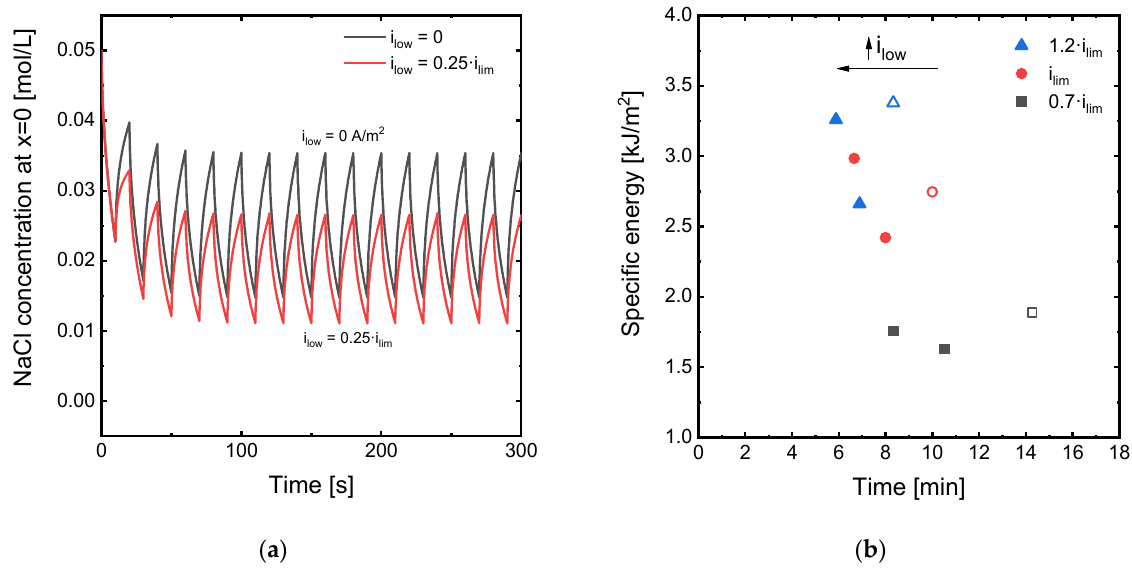
Figure 9. ( a ) Evolution with time of the NaCl concentration at the interface between the membrane surface and the diluting DBL (position x = 0) under the application of i lim in PEF mode with different values of i low applied during the relaxation periods; ( b ) trade-off between the specific energy consumption and the time needed to achieve a charge transport of 16,800 A·s at different levels of current density with t on = t off = 10 s and varying values of i low . Empty symbols represent the conditions for i low = 0 A/m 2 .